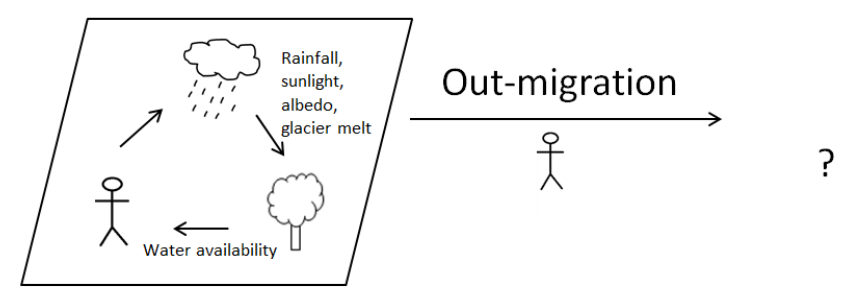
Fig. A1.6 Diagram drafted for the ABM described by Magallanes et al. (2014)